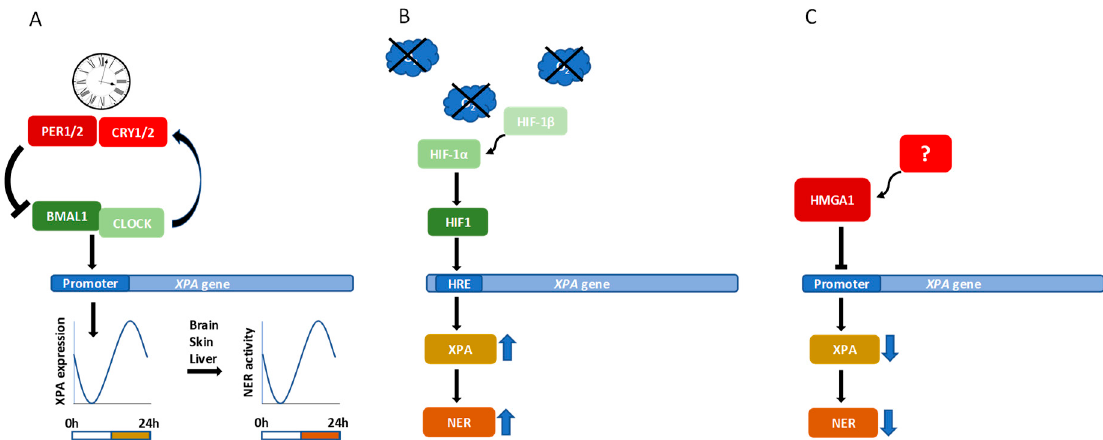
Figure 2. Transcriptional control of the XPA protein level. Transcription factors BMAL1 and CLOCK heterodimerize and drive the transcription of their negative regulators PER and CRY. This negative feedback loop sets up the rhythmic oscillation and drives circadian clocks. The BMAL1/CLOCK heterodimer also regulates the expression of XPA resulting in rhythmic oscillation of the XPA intracellular level and NER efficiency ( A ). In hypoxia, HIF-1 α forms a dimer with HIF-1 β . After translocation to nucleus, the HIF-1 heterodimer binds the HRE in promoter region of the XPA gene and upregulates expression of XPA leading to an increased NER efficiency ( B ). The HMGA1 protein binds to negative regulatory element in promoter region of the XPA gene and represses its transcription ( C ).